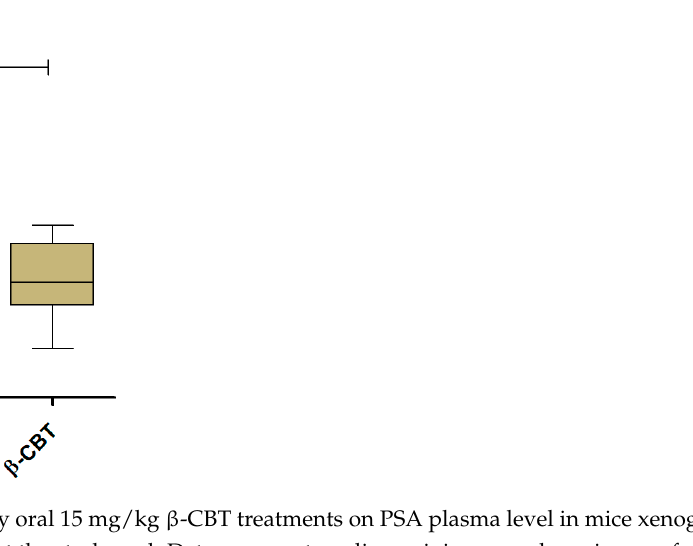
Figure 6. Comparison of the effects of daily oral 15 mg/kg oral β -CBT for 60 days on PC-3M PC cell locoregional and distant recurrence. ( A ) Bioluminescence intensity monitoring of PC-3M-Luc cells in intact animal shows the oral effect of vehicle control and ( B ) β -CBT 15 mg/kg daily oral treatments at the end of experiment course (60 days). ( C ) Bioluminescence comparison of animal organs for β - CBT-treated versus vehicle control-treated groups collected at the study end. ( D ) Number of meta- static organs in β -CBT-treated group versus vehicle control group. ( E ) Comparative monitoring of the effects of β -CBT versus vehicle control treatments on the mean mice total body weight over the recurrence-phase course (60 days). Data points represent mean body weight per group in g ± SD. The mean body weights comparison between vehicle-treated control and β -CBT-treated groups was statistically non-significant, p < 0.05. 3.5. β -CBT Reduced Mice Plasma Total Prostate-Specific Antigen (PSA)